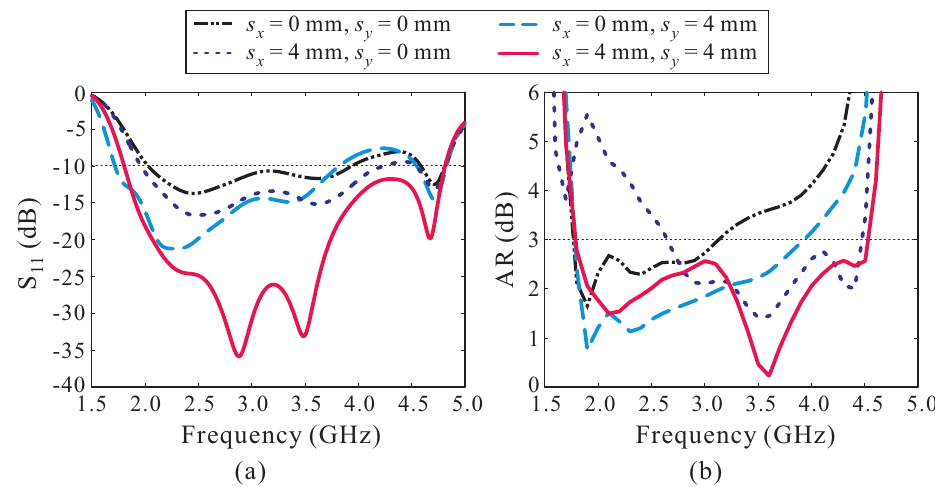
Figure 3. Effect of the position of circular patch loading O 1 on antenna performance: ( a ) reflection coefficients; ( b ) ARs.